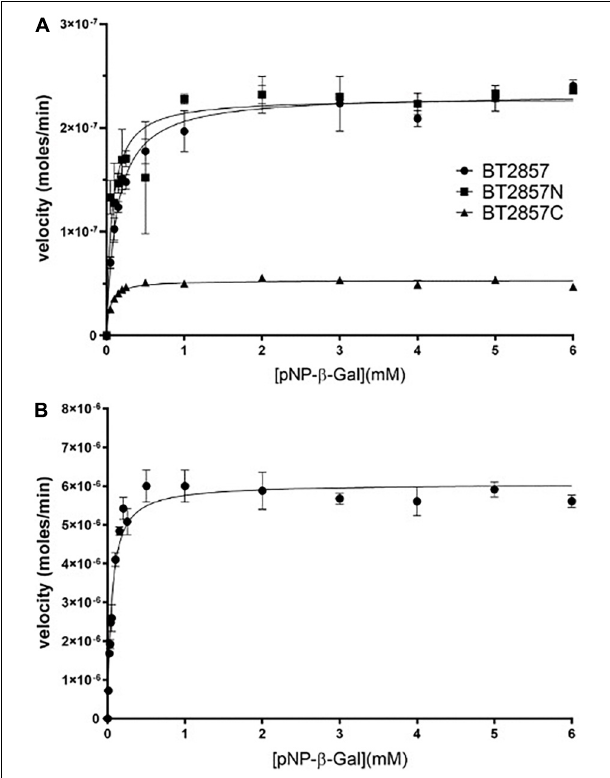
FIGURE 6 | Kinetic analysis of BT2857, BT2857 C-/N-terminal truncations (A) , and BT3158 (B) using para-nitrophenyl- β -D-galactopyranoside. Reaction volumes of 250 µ L were used to assay each protein present at a final concentration of 5 µ M ( n = 3). BT2857 was determined to have a V max , K M , and k cat of 2.32 × 10 − 7 moles/min ( ± 3.83 × 10 − 9 ), 0.13 mM ( ± 0.010), and 0.046 s − 1 , respectively. BT2857N was determined to have values of 2.29 × 10 − 7 moles/min ( ± 6.59 × 10 − 9 ), 0.07 mM ( ± 0.012), and 0.046 s − 1 ; while BT2857C generated values of 5.31 × 10 − 8 moles/min ( ± 8.09 × 10 − 10 ), 0.047 mM ( ± 0.005), and 0.011 s − 1 . BT3158 was determined to have a V max , K M , and k cat of 6.06 × 10 − 6 moles/min ( ± 1.7 × 10 − 7 ), 0.052 mM ( ± 0.007), and 1.21 s − 1 , respectively.